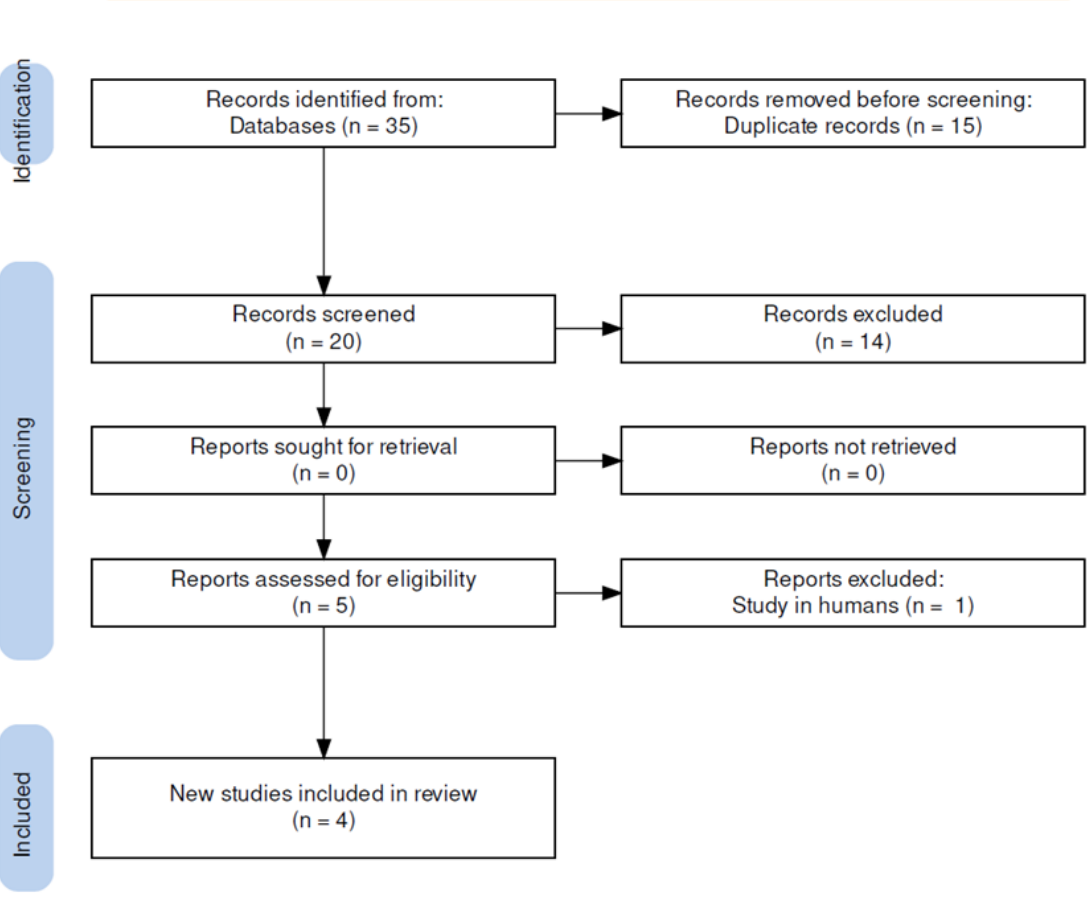
Figure 1. Flow chart.